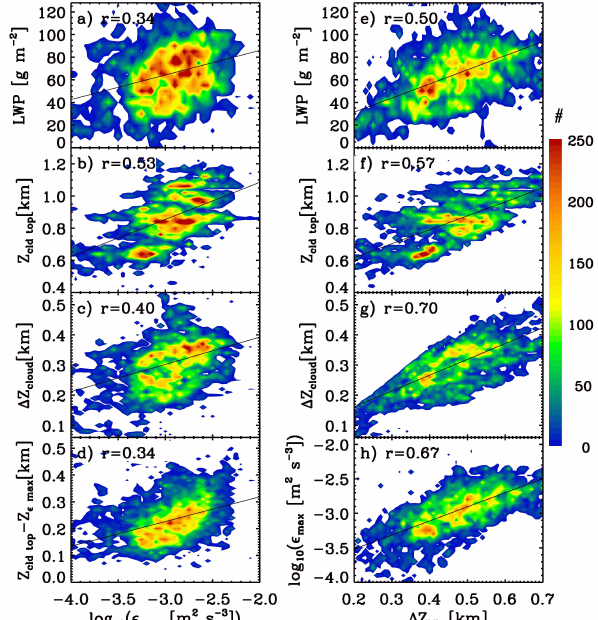
Fig. 15. Two-dimensional frequency distributions of the layer- maximum turbulent dissipation rate versus (a) LWP, (b) cloud-top height, (c) cloud thickness, and (d) distance from cloud top to the height of the maximum ε , and the mixed-layer depth versus (e) LWP, (f) cloud-top height, (g) cloud thickness, and (h) layer- maximum ε . Data included are only for cases where the mixed- layer base is identified to be above 0.15km and all data have been subjected to a 10min running average. Each panel includes the cor- relation coefficient and the least absolute deviation best linear fit to the